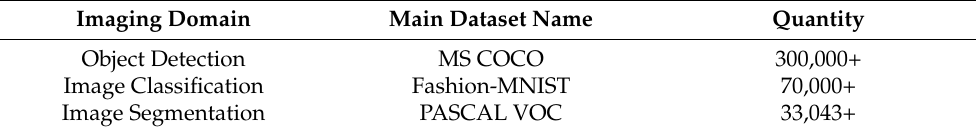
Table 1. Comparison of the number of datasets in the deep learning image